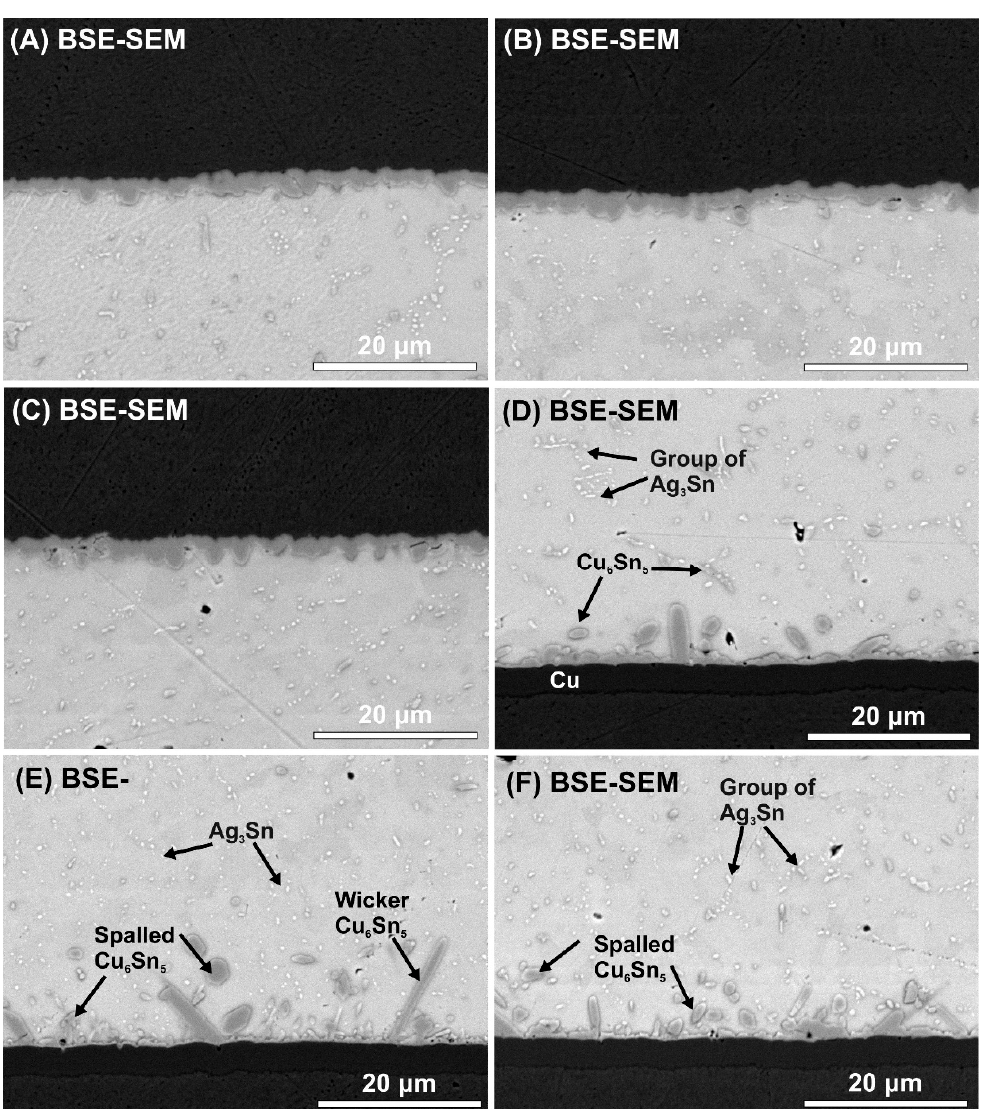
Figure 7. BSE-SEM micrographs of IMC layers in the different samples: ( A ) upper IMC layer in a SACX0307 sample; ( B ) upper IMC layer in a SACX0307-TiO 2 sample; ( C ) upper IMC layer in a SACX0307-nano TiO 2 sample; ( D ) bottom IMC layer in a SACX0307 sample; ( E ) bottom IMC layer in a SACX0307-TiO 2 sample; ( F ) bottom IMC layer in a SACX0307-nano TiO 2